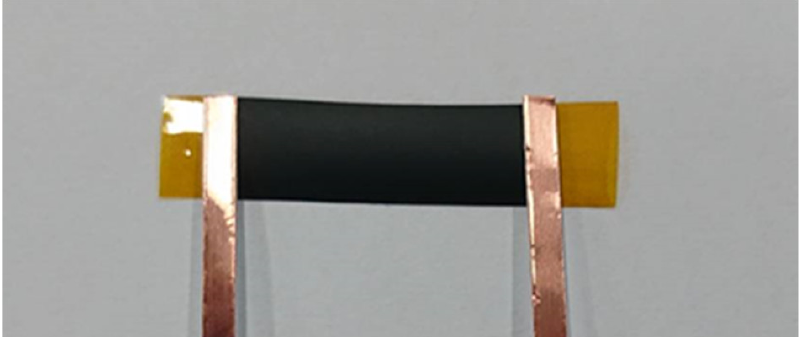
Figure 3. Strain sensitivity test specimen.